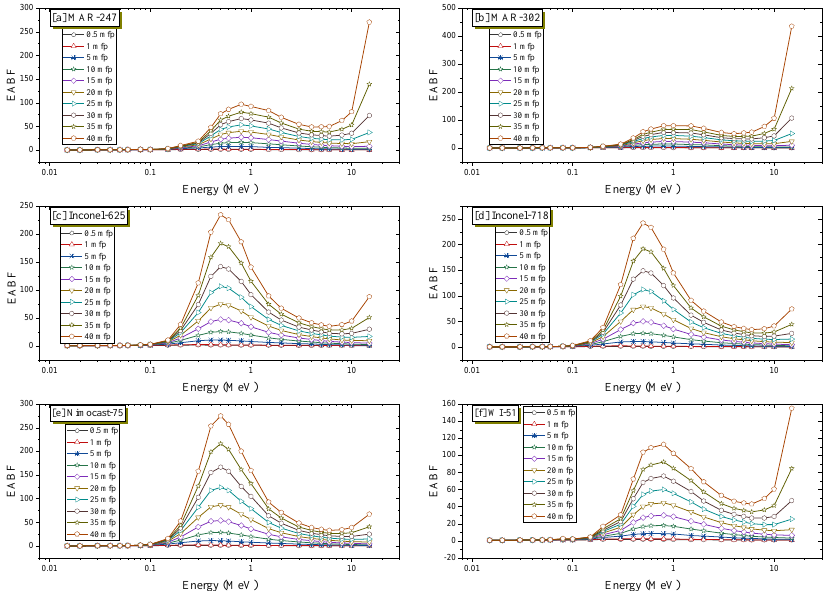
Figure 6. Variation of the energy absorption buildup factor versus the gamma-ray energy at various penetration depths.for the investigated alloys: ( a ) MAR-247, ( b ) MAR-302, ( c ) Inconel-625, ( d ) Inconel-718, ( e ) Nimocast-75, ( f )